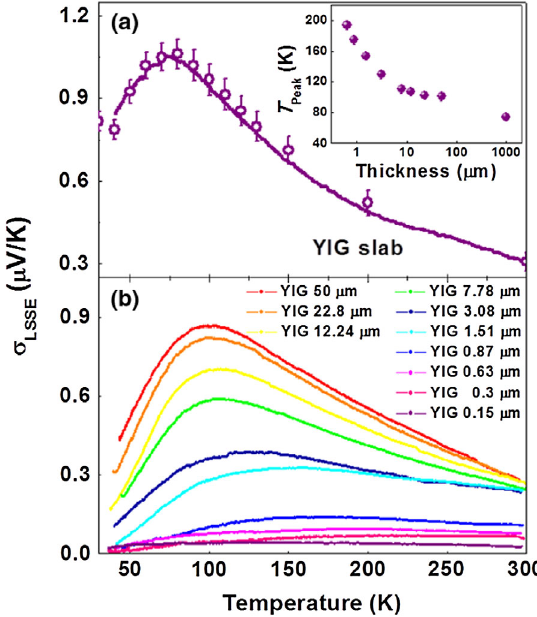
FIG. 1. Temperature-dependent LSSE coefficients ( σ ) of LSSE (a) a YIG slab and (b) YIG thin films with a wide range of thicknesses. The open symbols in (a) represent the results recorded by field-sweep mode measurements. The inset of (a) shows the peak position of the σ - T curves as a function of film LSSE